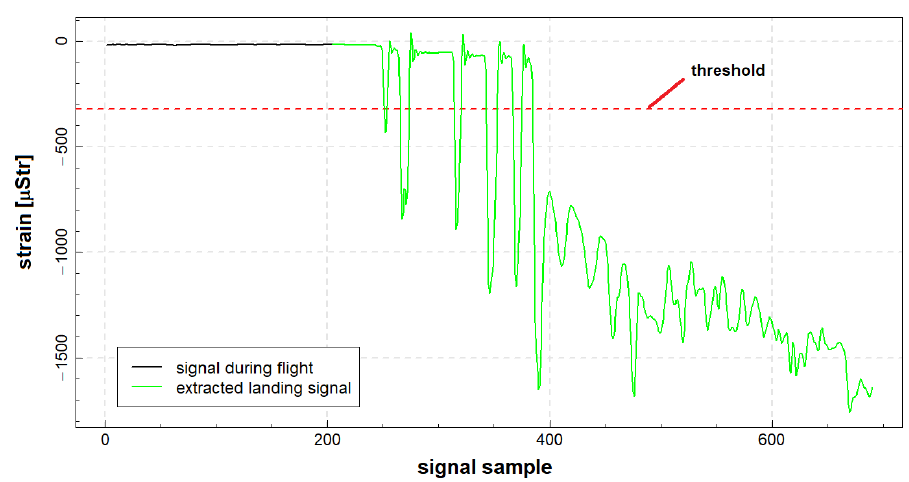
Figure 8. An example of automated extraction of signal corresponding to full stop